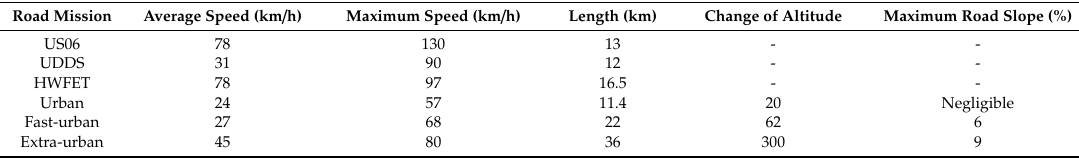
Table 4. Road mission